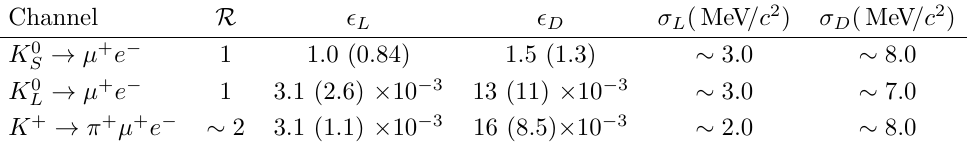
Table 3 . Acceptance scale factors (cid:15) , and mass resolutions (cid:27) , for only long ( L ) and only down- stream ( D ) tracks obtained from our simpli(cid:12)ed description of the LHCb Upgrade tracking system geometry. All e(cid:14)ciencies are normalised to that of fully reconstructed K 0 between particles and anti-particles. The invariant-mass resolutions shown in the table correspond to the ideal case of perfect bremsstrahlung